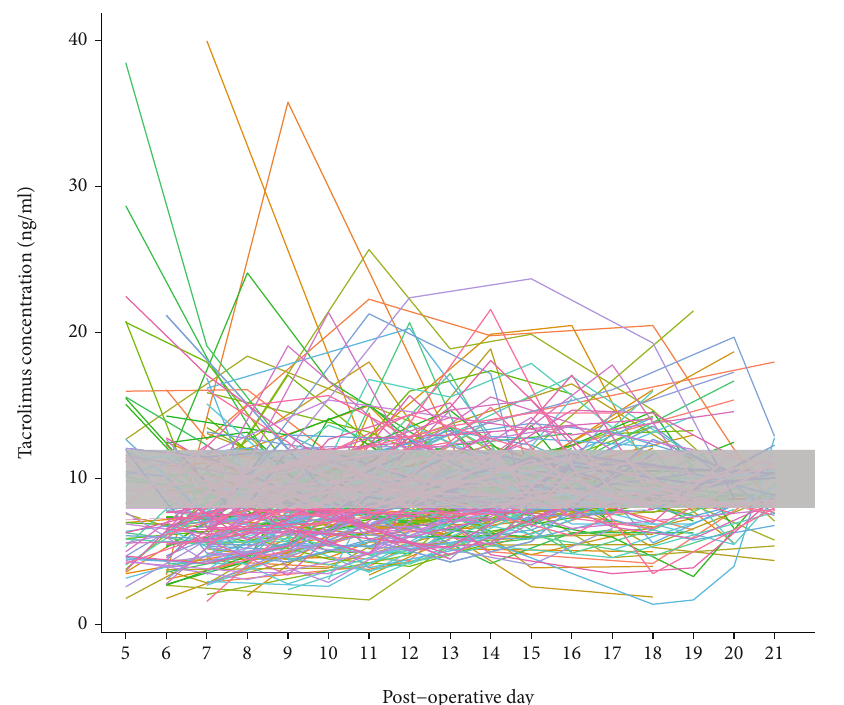
Figure 1: Individual trends of tacrolimus concentration.